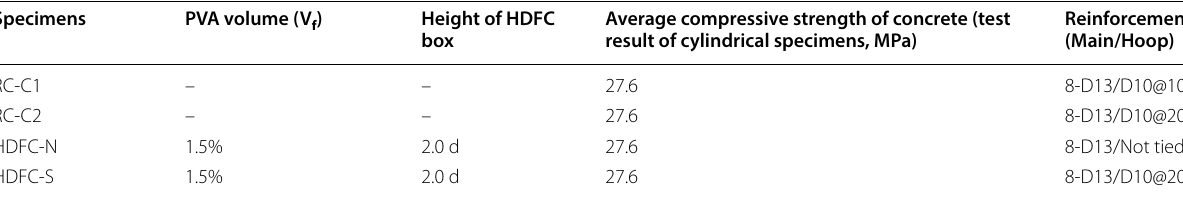
Table 2 Variables of specimens.